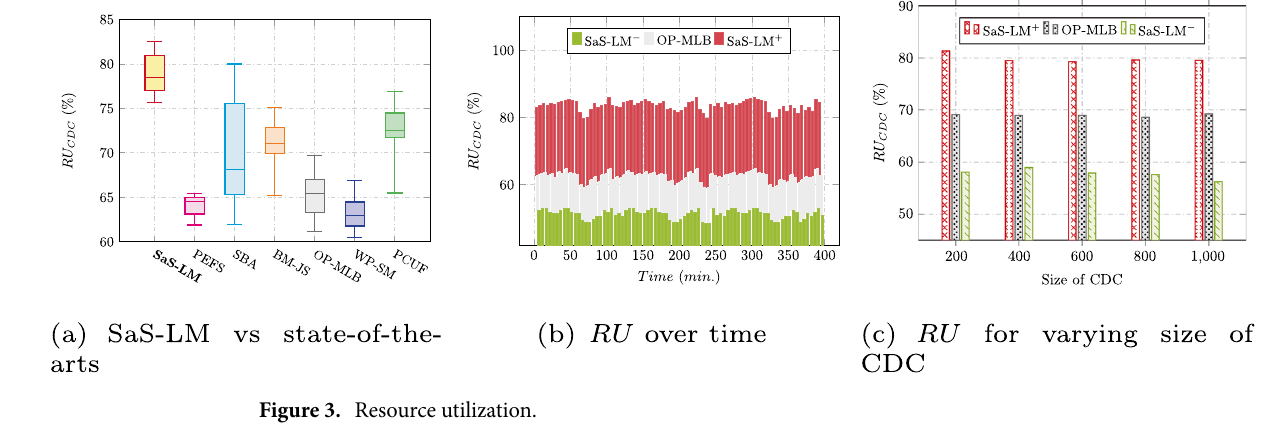
Figure 3. Resource